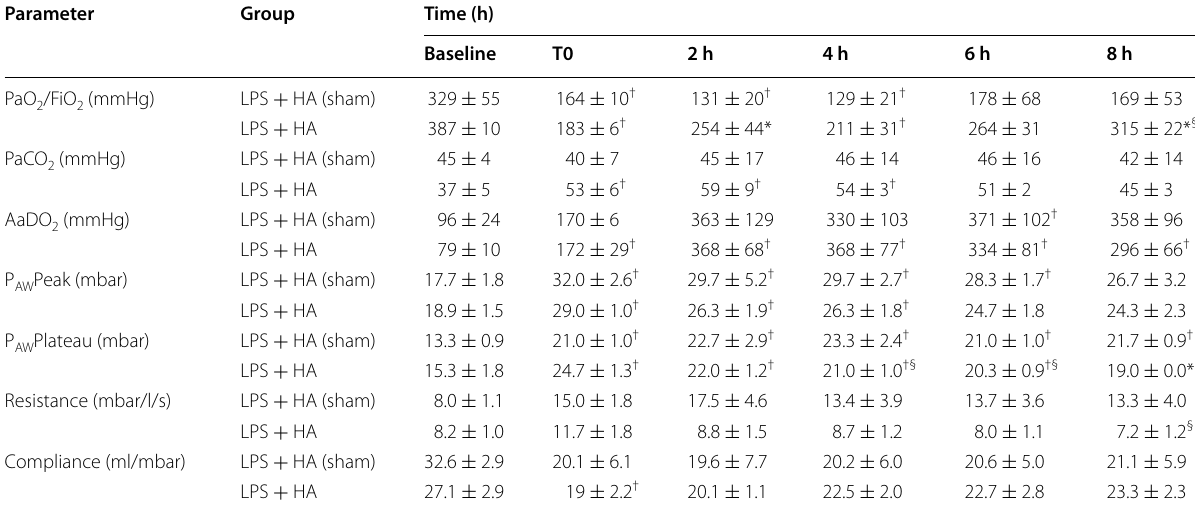
HA (sham)- and LPS HA-treated animals + +